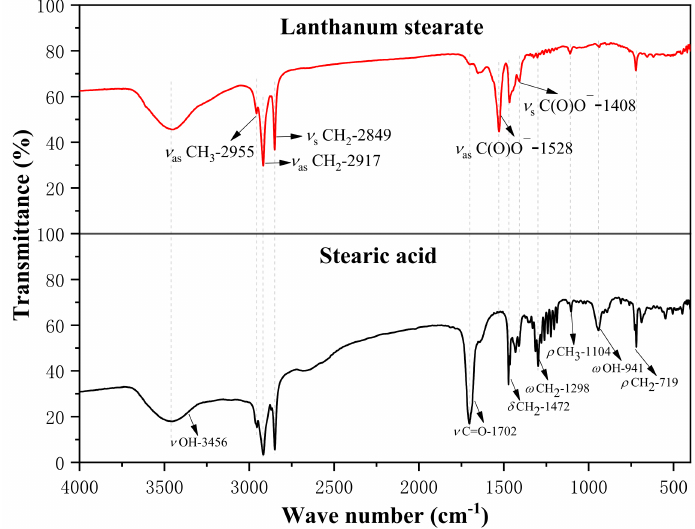
Figure 3. Infrared spectra of stearic acid and lanthanum